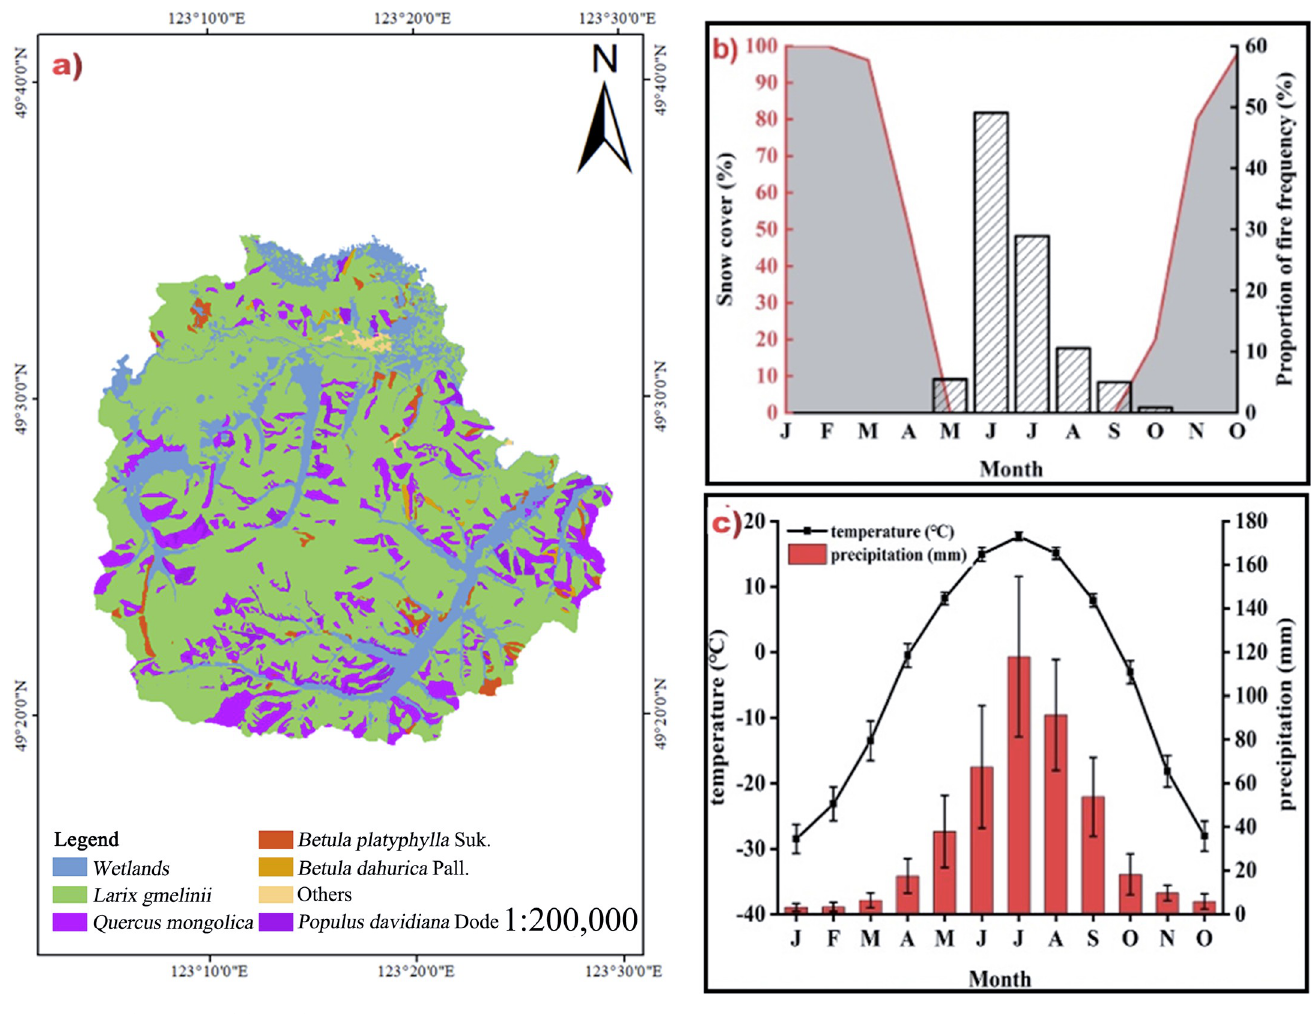
Fig 1. Basic information of the study